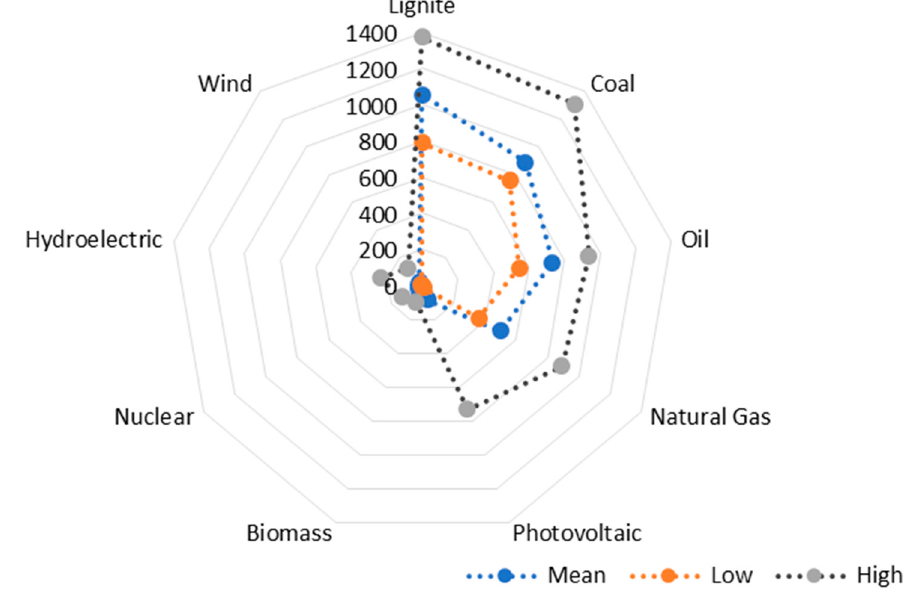
Figure 18. Comparison of lifecycle greenhouse gas emissions of various electricity generation sources [113].